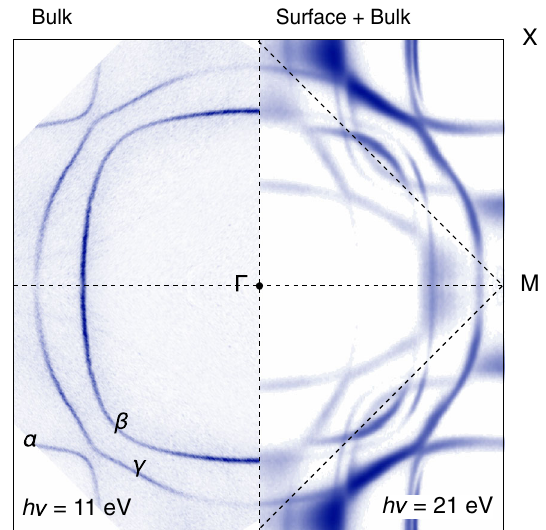
FIG. 7. Bulk and surface electronic structure of Sr 2 RuO 4 . Left half: Fermi surface map of a CO passivated surface shown in the main text. Right half: Fermi surface acquired on a pristine cleave at 21 eV photon energy. Intense surface states are evident in addition to the bulk bands observed in the left